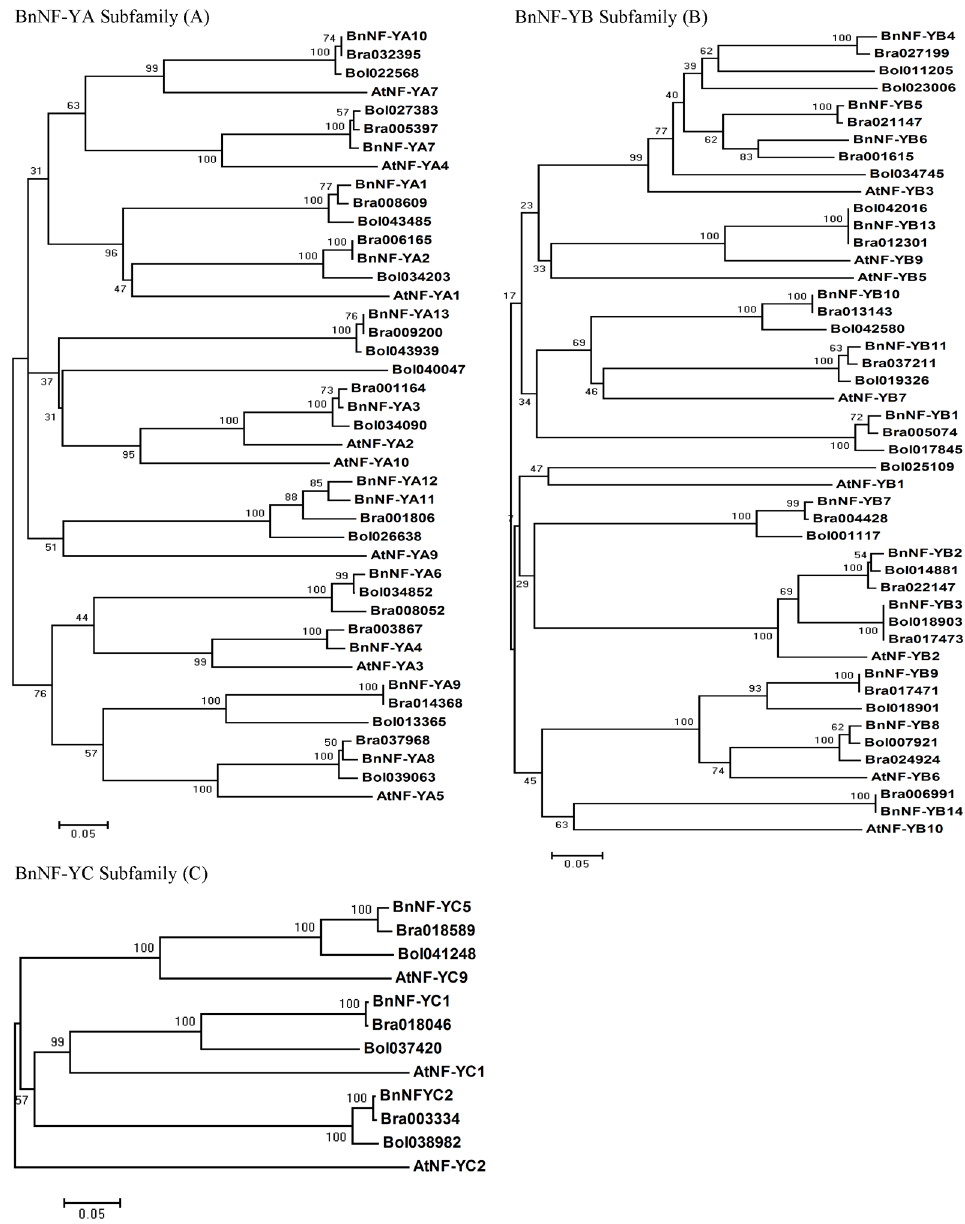
Figure 6. Phylogenetic trees of Brassica and Arabidopsis NF-Y families based on the nucleotide sequences in the promoter regions. The phylogenetic trees were constructed by the neighbor-joining method implemented by MEGA software, version 4.1. The numbers at each branch point represent the bootstrap scores (1,000 replicates). A branch with a bootstrap score of below 50 was usually considered unreliable. a Phylogenetic tree of Brassica and Arabidopsis NF-YA promoters. Due to low levels of nucleotide similarity, BnNF-YA4 homologues in B. oleracea were not included here. b Phylogenetic tree of Brassica and Arabidopsis NF-YB promoters. Due to low levels of nucleotide similarity, BnNF-YB14 homologues in B. oleracea were not included here. c Phylogenetic tree of Brassica and Arabidopsis NF-YC promoters. Bol and Bra represent B. oleracea and B. rapa , respectively. The numbers after the species abbreviation correspond to the individual gene name. Most promoters were at least 1000 bp in length, except for those of BnNF-YA1 (595 bp), BnNF-YA4/5 (577), BnNF-YA6 (806), BnNF-YA10 (892), BnNF-YB1 (519), BnNF-YB7 (988), BnNF-YB8 (391), and BnNF-YB13 (867) and their homologues in B. oleracea , B. rapa, and Arabidopsis .